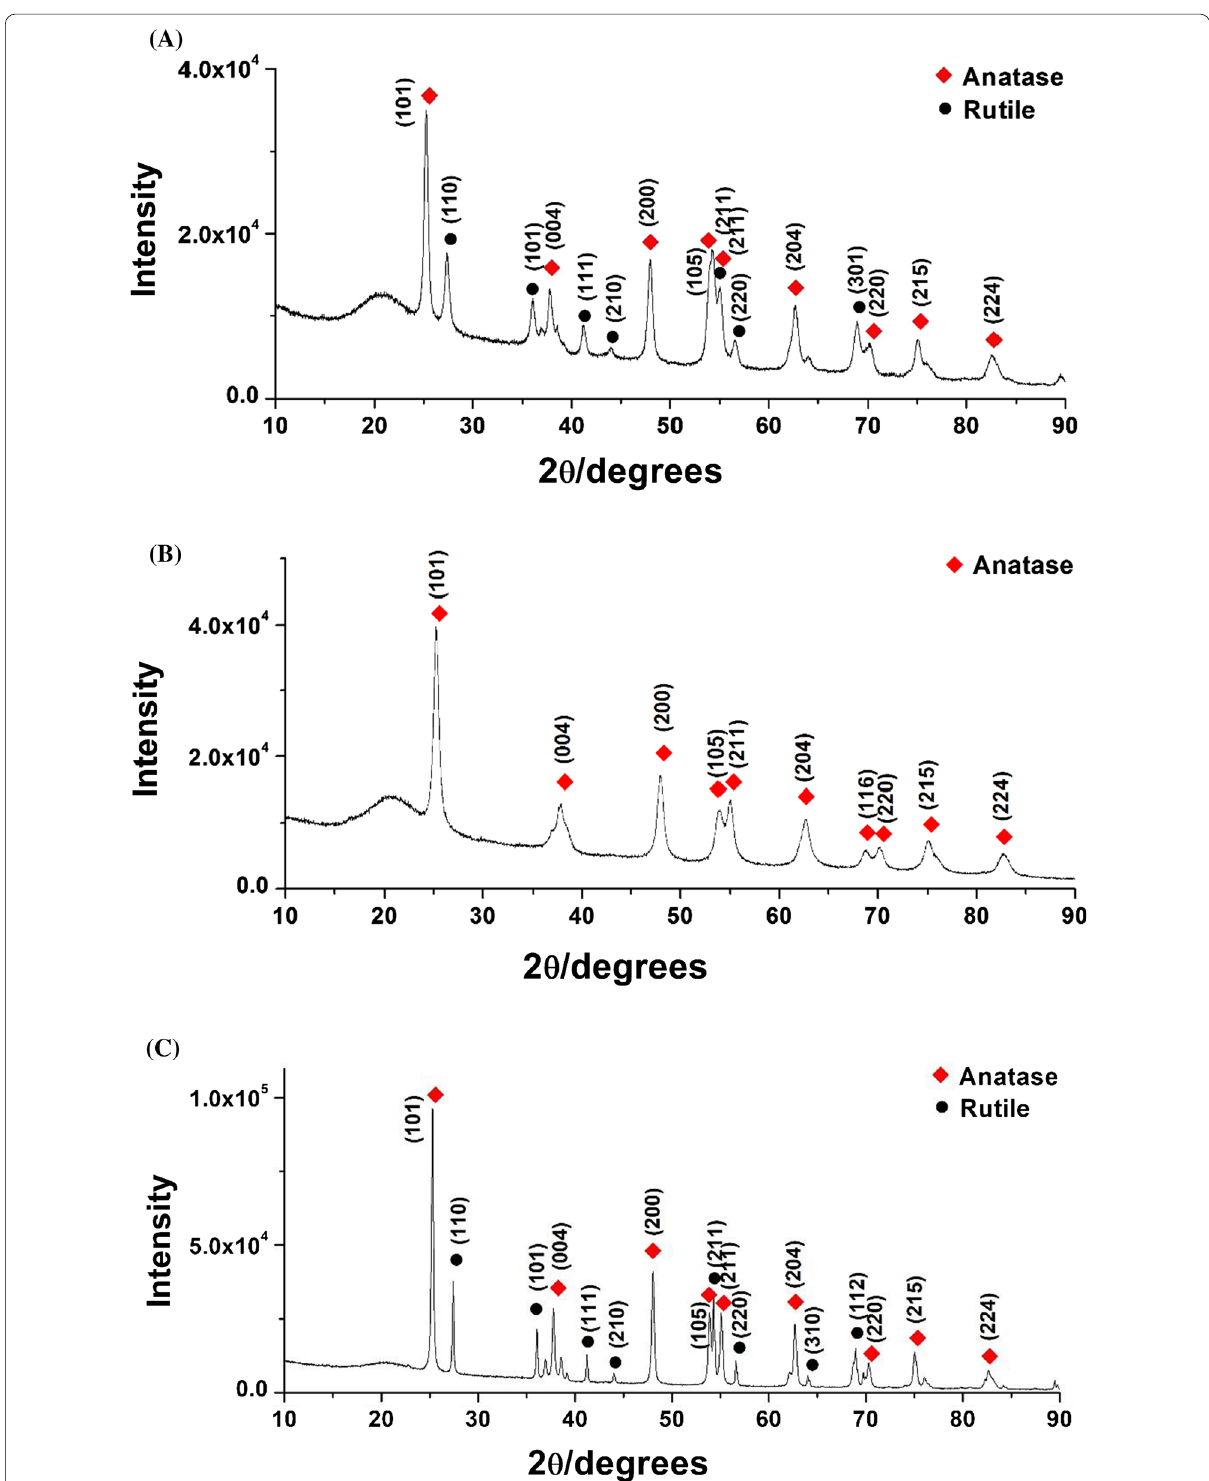
Fig. 4 HR‑XRD patterns of TiO 2 NPs. a MeOH‑TiO 2 NPs, b EtOAc‑TiO 2 NPs, and c Con‑TiO 2